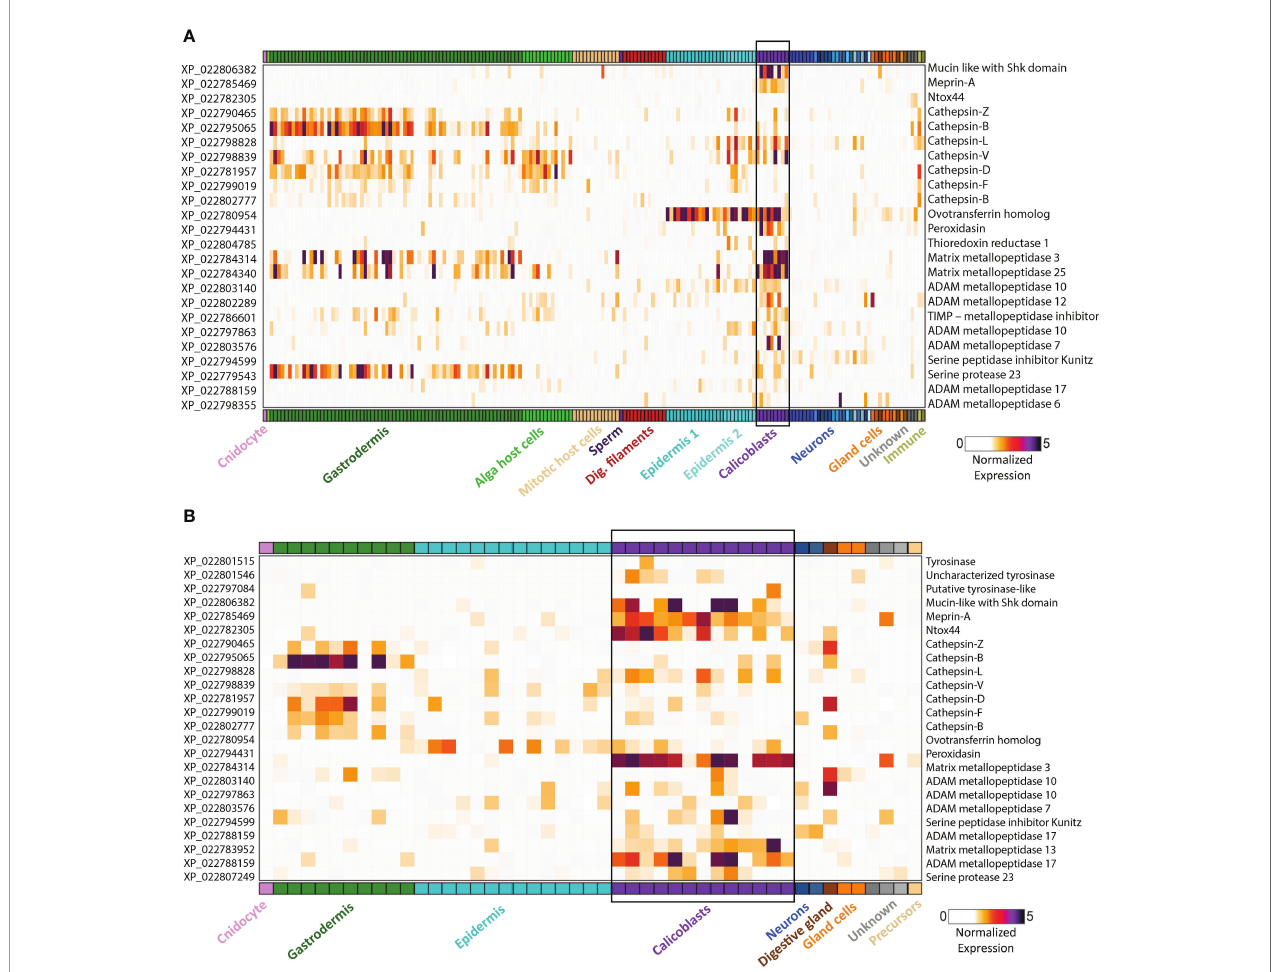
FIGURE 2 | Gene expression heatmap for selected genes that might play a dual role in biomineralization and immunity. Expression levels (fold-change) are shown across all cell types of the stony coral S. pistillata . Calicoblast cells are in purple and are emphasized with a black box (A) Adult gene expression heatmap of selected genes. (B) Primary polyp gene expression heatmap of selected genes. Heatmaps were created using the interactive database https://sebe-lab.shinyapps.io/ Stylophora_cell_atlas/